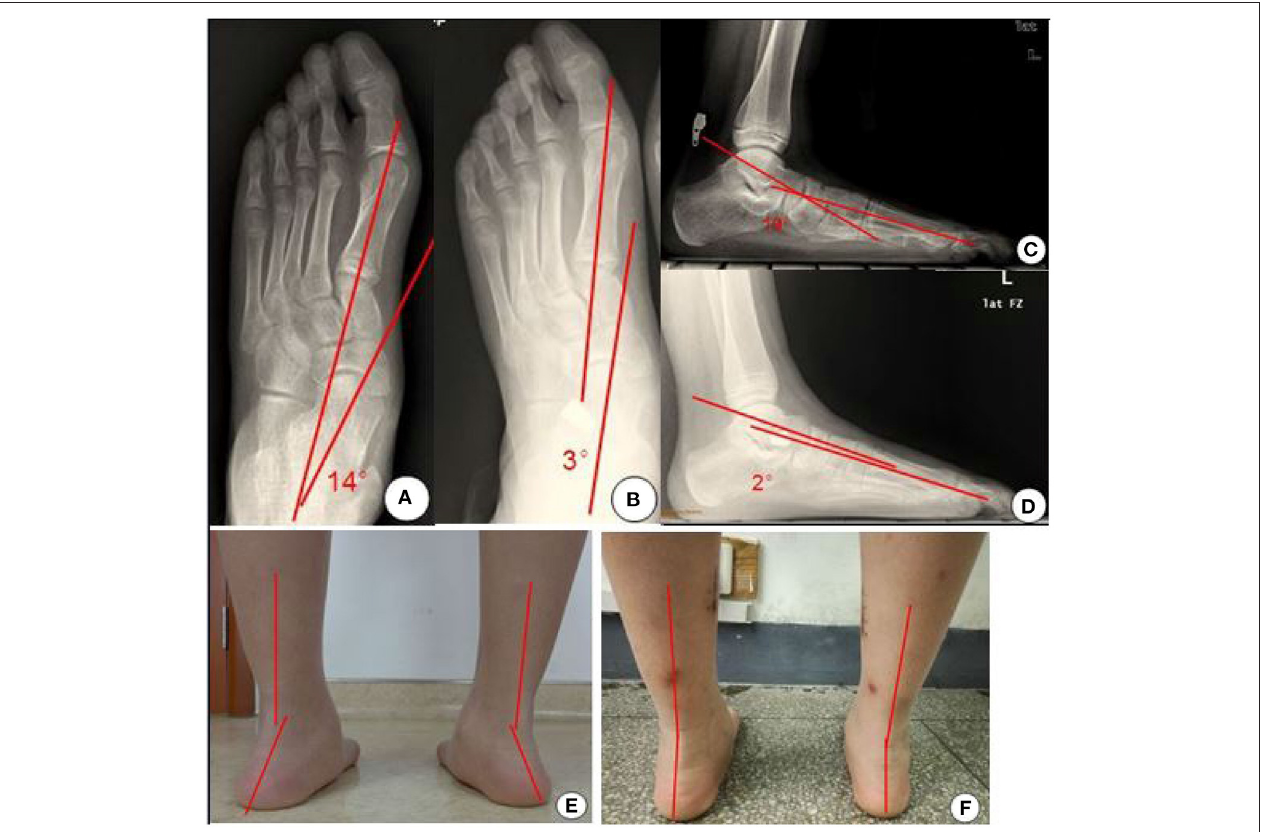
FIGURE 1 | X-ray films and appearance photos before and after operation. (A) The left foot X-ray film (AP) before operation. (B) The left foot X-ray film (AP position) after operation. (C) The lateral X-ray film of the left foot before operation. (D) The lateral X-ray film of the left foot after operation. (E) The posterior foot line of force before operation. (F) The posterior foot line of force after